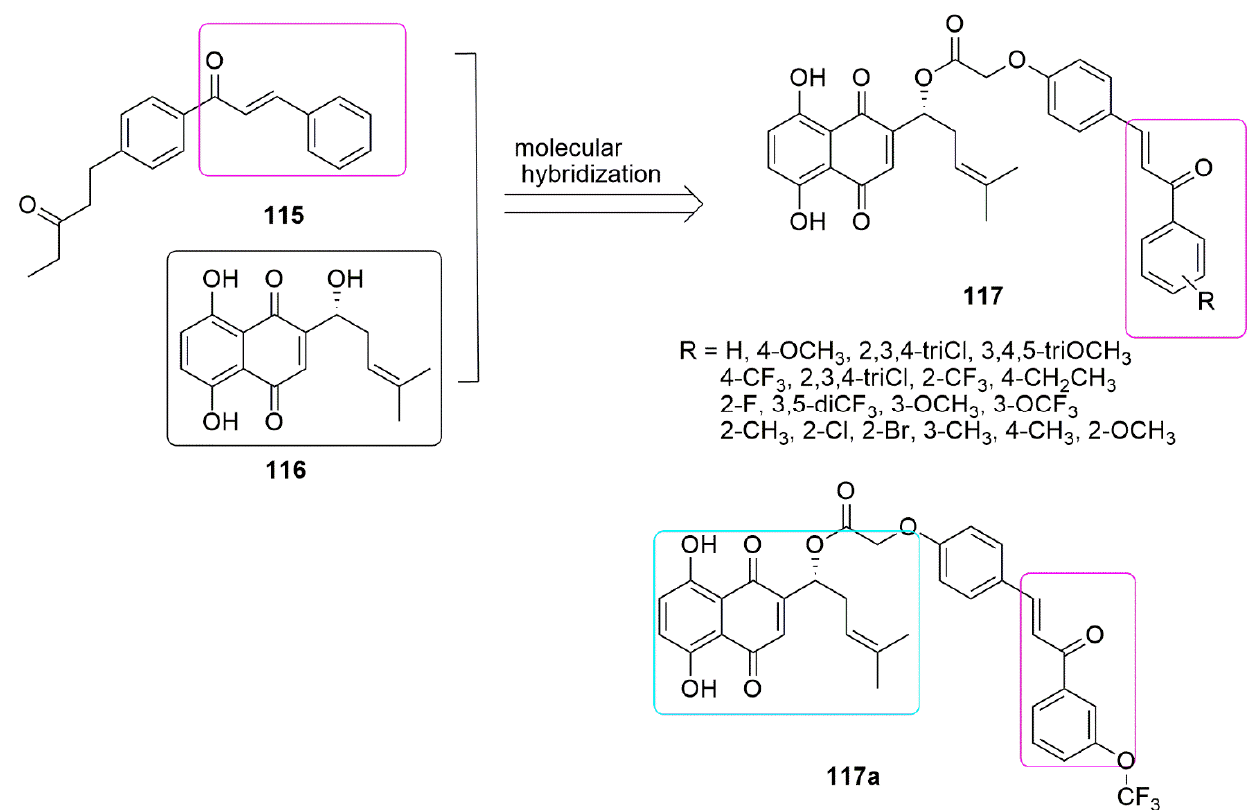
Figure 34. Chemical structures of novel chalcone-containing shikonin derivative. Based on the panorama, the 3,4,5-trimethoxyphenyl (TMP) moiety of CA-4 is respon- sible for its strong activity because of the formation of a hydrogen bond between the 4-methoxyl group and residue Cys241 [100]. Xu and colleagues expected that the N -1 atom of pyridine would also form a hydrogen bond with residue Cys241 in the colchicine binding sit. They replaced the trimethoxyphenyl ring of 104 with the pyridine 119 scaffold. A series of novel pyridine-chalcone ( 120 – 121 ) derivatives as potential anti-tubulin agents have been reported [101]. Compound 121a exhibited the most potent activity with the IC 50 values ranging from 0.023–0.047 µ M against four panels of cancer cell lines and one normal cell line. Compound 121a (R 1 = R 2 = R 4 = OCH 3 , R 3 = OH, and R 5 = H) demonstrated an IC 50 value of 0.023 µ M against K562 cell lines which was ~3-fold superior to compound 104 . The methyl-substituted at the α -position of an unsaturated carbonyl group in 120 , 121 series were favored for their inhibitory activity. Meanwhile, the hydroxyl on ring B was crucial for maintaining the inhibitory activity of 121 hybrids. In addition, the substitution of electron-donating groups on the pyridine ( 121 ) enhanced the activity compared to electron- withdrawing groups. The authors reported that electron-withdrawing groups improved the electron density of the N -1 of pyridine, thus allowing the interaction of the compound with residue Cys241 through H-bonding as they expected. The 3-substituted indoles exhibited good inhibitory activity ( 124, 125 ), while substituents at N -1 of the indole ring showed low inhibitory activity against K562 ( 126-128 ). Compound 121a inhibited su- perior tubulin polymerization with an IC 50 value of 2.08 µM, compared to CA-4 (IC50 = 2.17 µM). The potent compound further caused G2/M phase arrest, induced cell apoptosis, and disintegrated the intracellular microtubule assembly. Compound 121a positively in- hibited the tumor volume and lessen the tumor weight (65.8% at 20 mg/kg per day (i.v.)), compared to the reference compound CA-4 1 (50.9% at 20 mg/kg) or CA-4P (62.7% at 20 mg/kg). The active compound also acts as a vascular disrupting agent (see Figure 35).